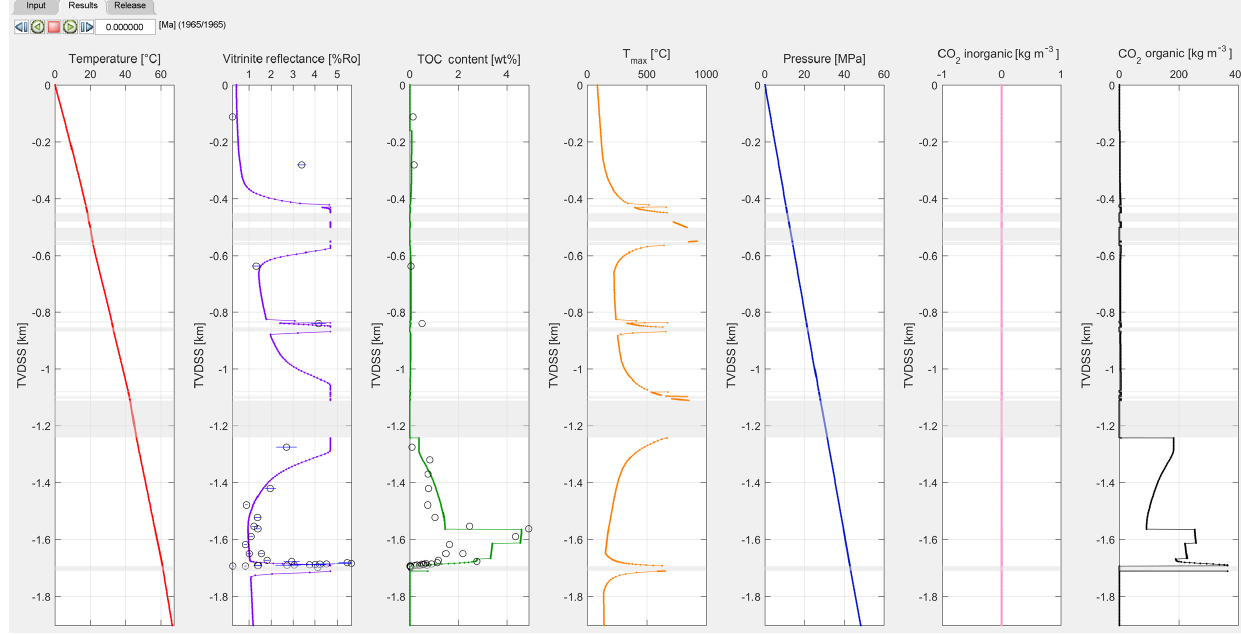
Figure 11. Results tab at the end of the simulation time for LA1/68 shows a good match to present-day TOC and VR values.